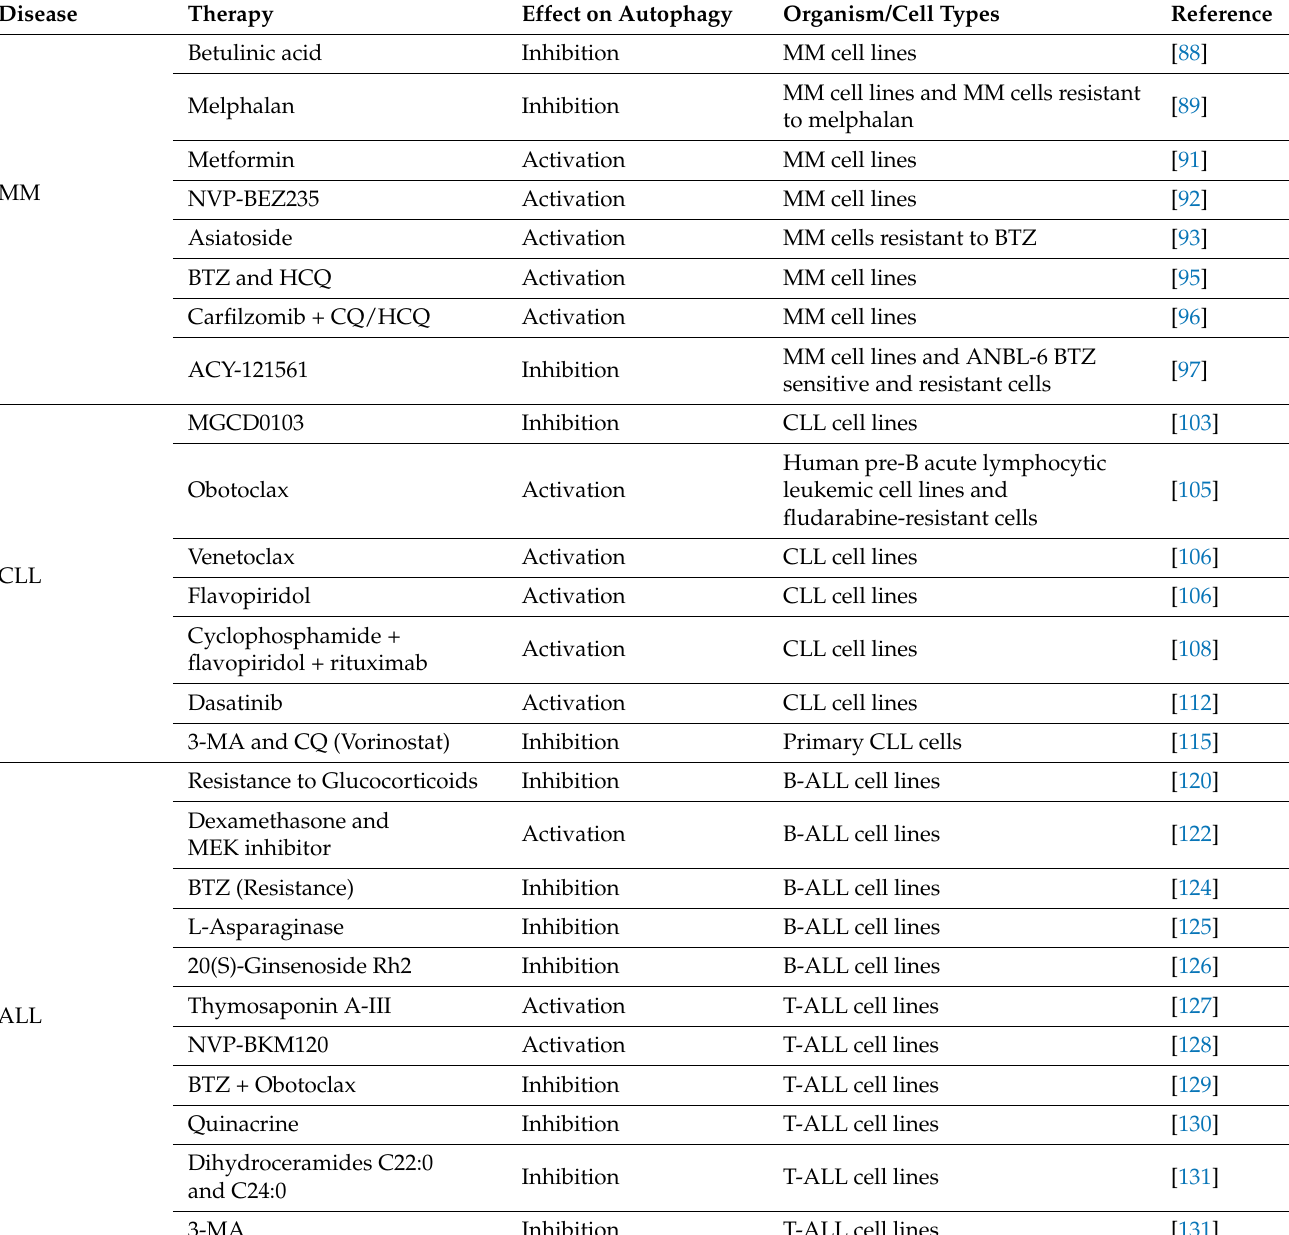
Table 1. Description of autophagy findings in different hematological